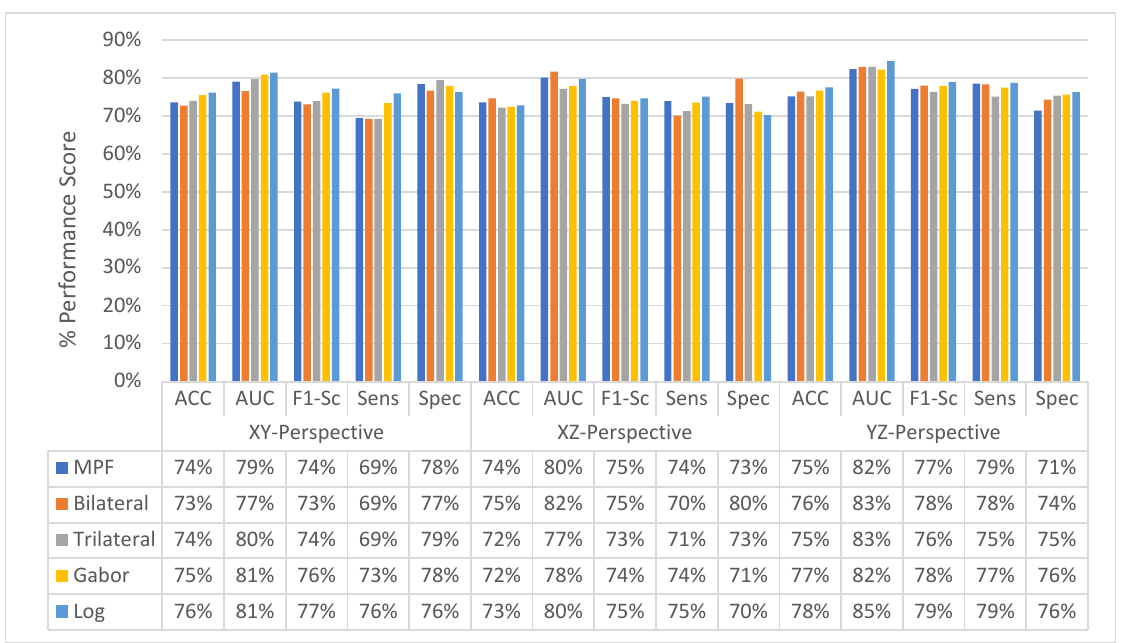
Figure 34. Change in slice-level classification performances for proposed SFMPF and MPF models for each perspective.